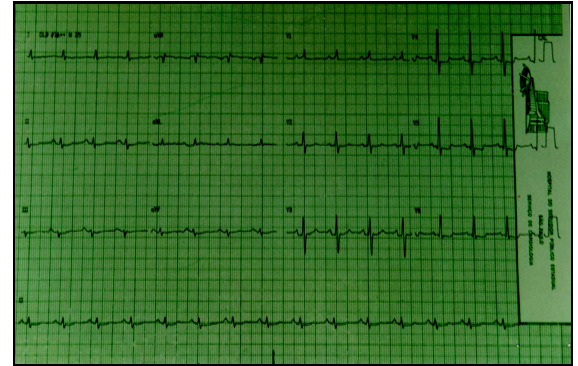
Fig. 2 - Eletrocardiograma pré-operatório, com ritmo sinusal, sobrecar- gas de átrio esquerdo e ventrículo direito.